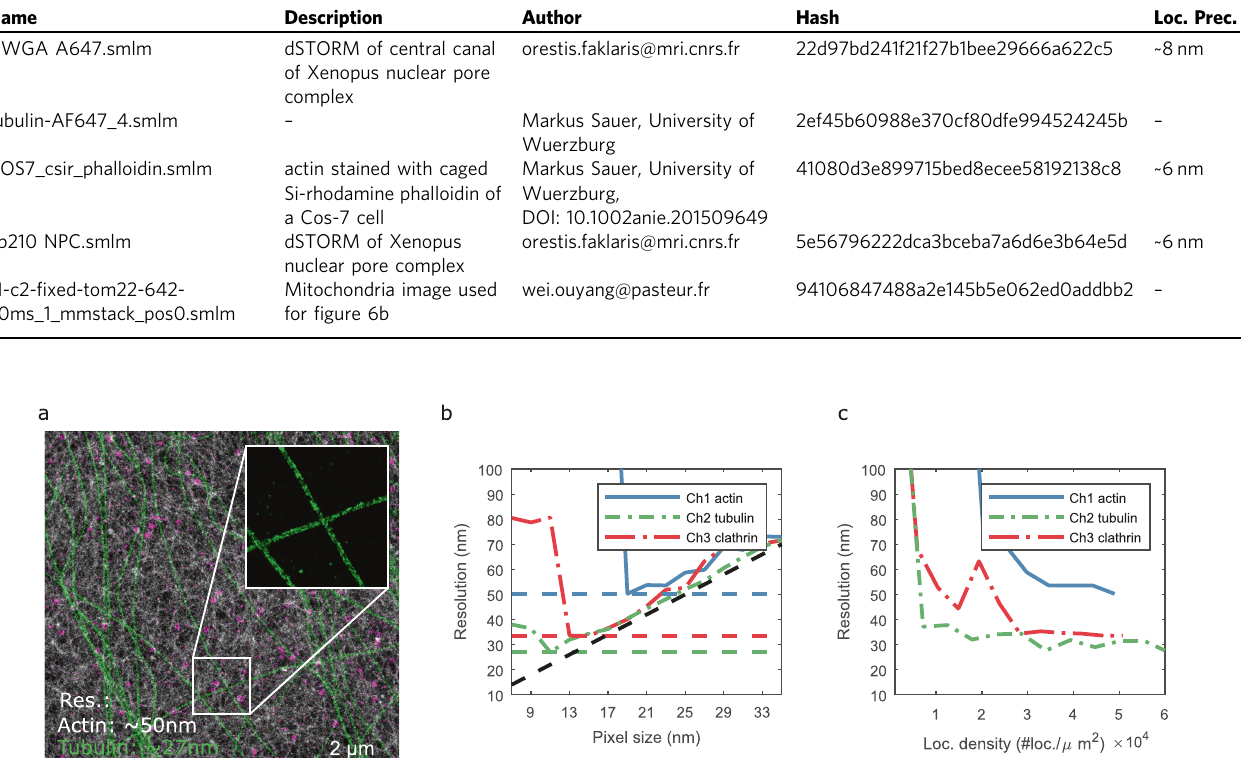
Table 1 Selected https://shareloc.xyz/#/ data.